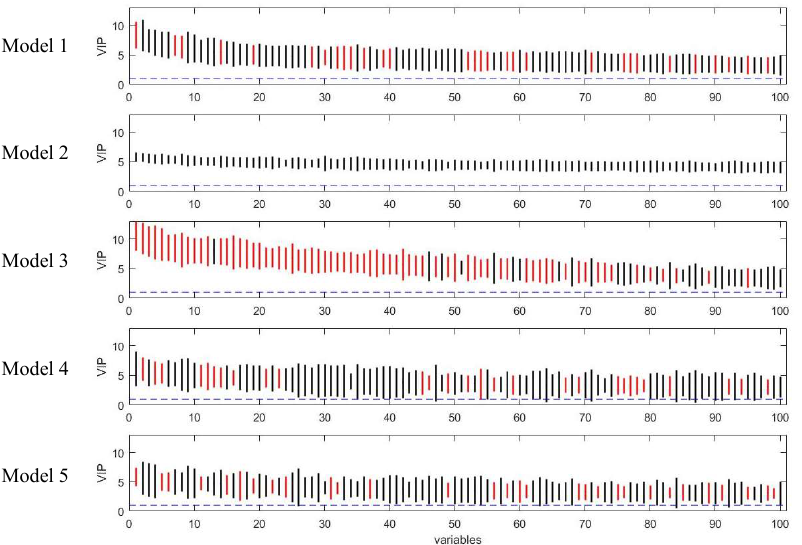
Figure 6. Rank of VIP scores for the discriminating variables in five PLS models on simulated Dataset 3. Bootstrapped VIP scores for all the variables were ranked according to their mean VIP scores in descending order. Bars show the mean +/- one standard deviation. Red and black represent the variables which are discriminating or non-discriminating, respectively. The horizontal blue dash line corresponds to VIP = 1.